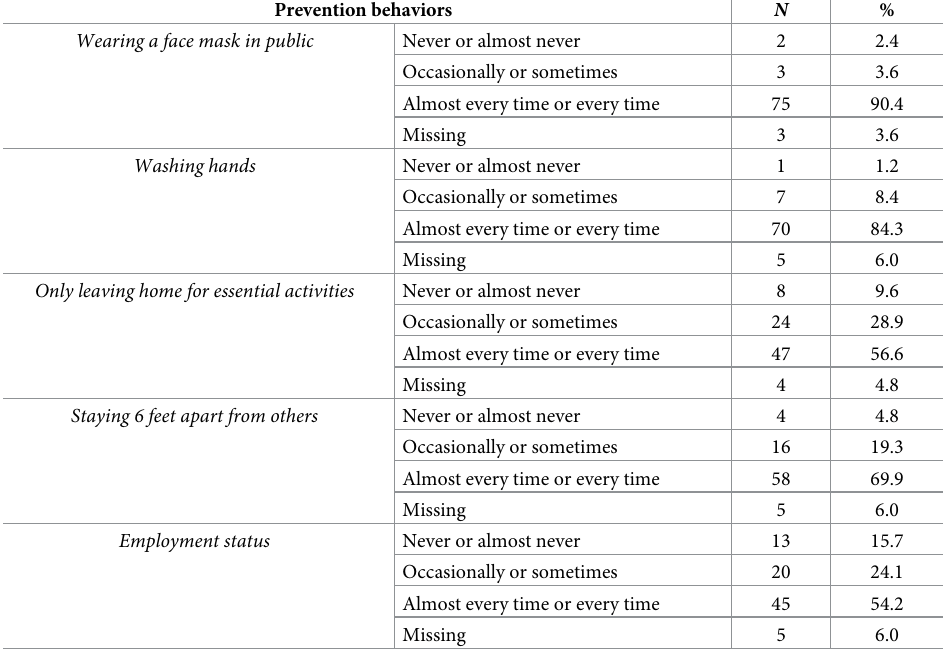
Table 2. Frequency of prevention behaviors in past 2 months (N =